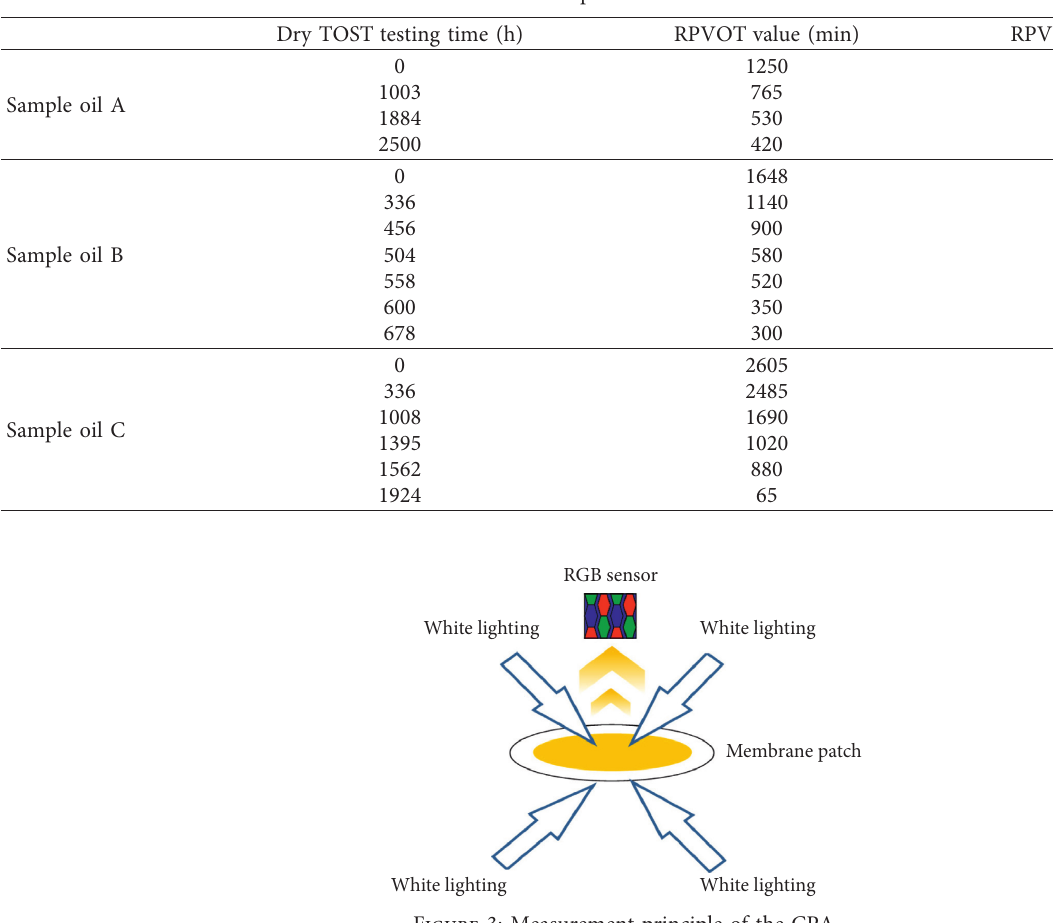
Figure 2: Magnified images of the membrane filter. (a) Surface. (b) Cross section. Table 1: Properties of the solvents.